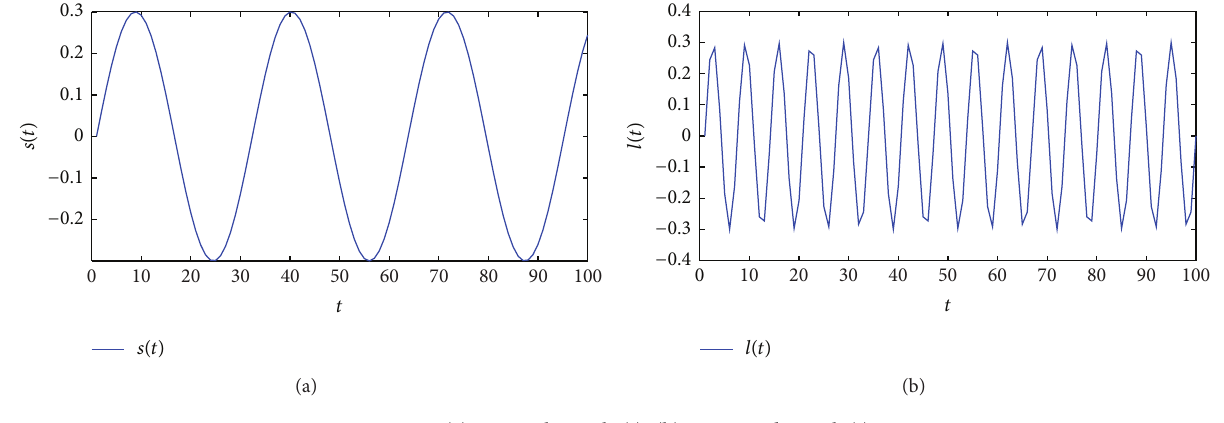
Figure 5: (a) Original signal 𝑠(𝑡) . (b) Encrypted signal 𝜄(𝑡) .